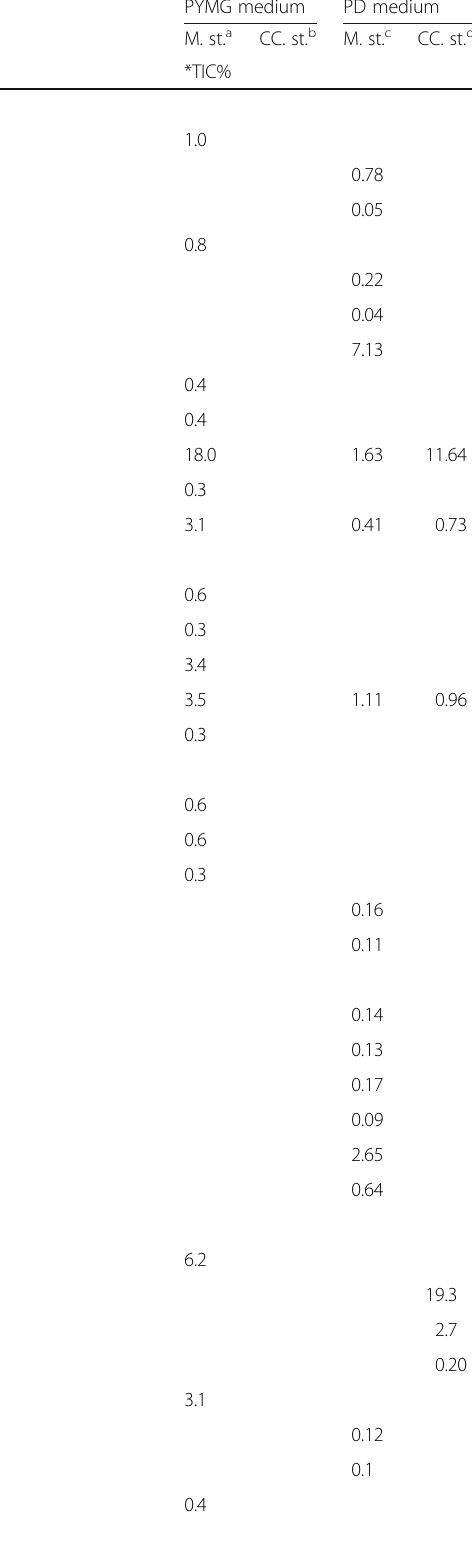
Table 1 Chemical composition assessed by GC/MS analysis for fungal extracts with high antimicrobial activities from different media for Aspergillus unguis